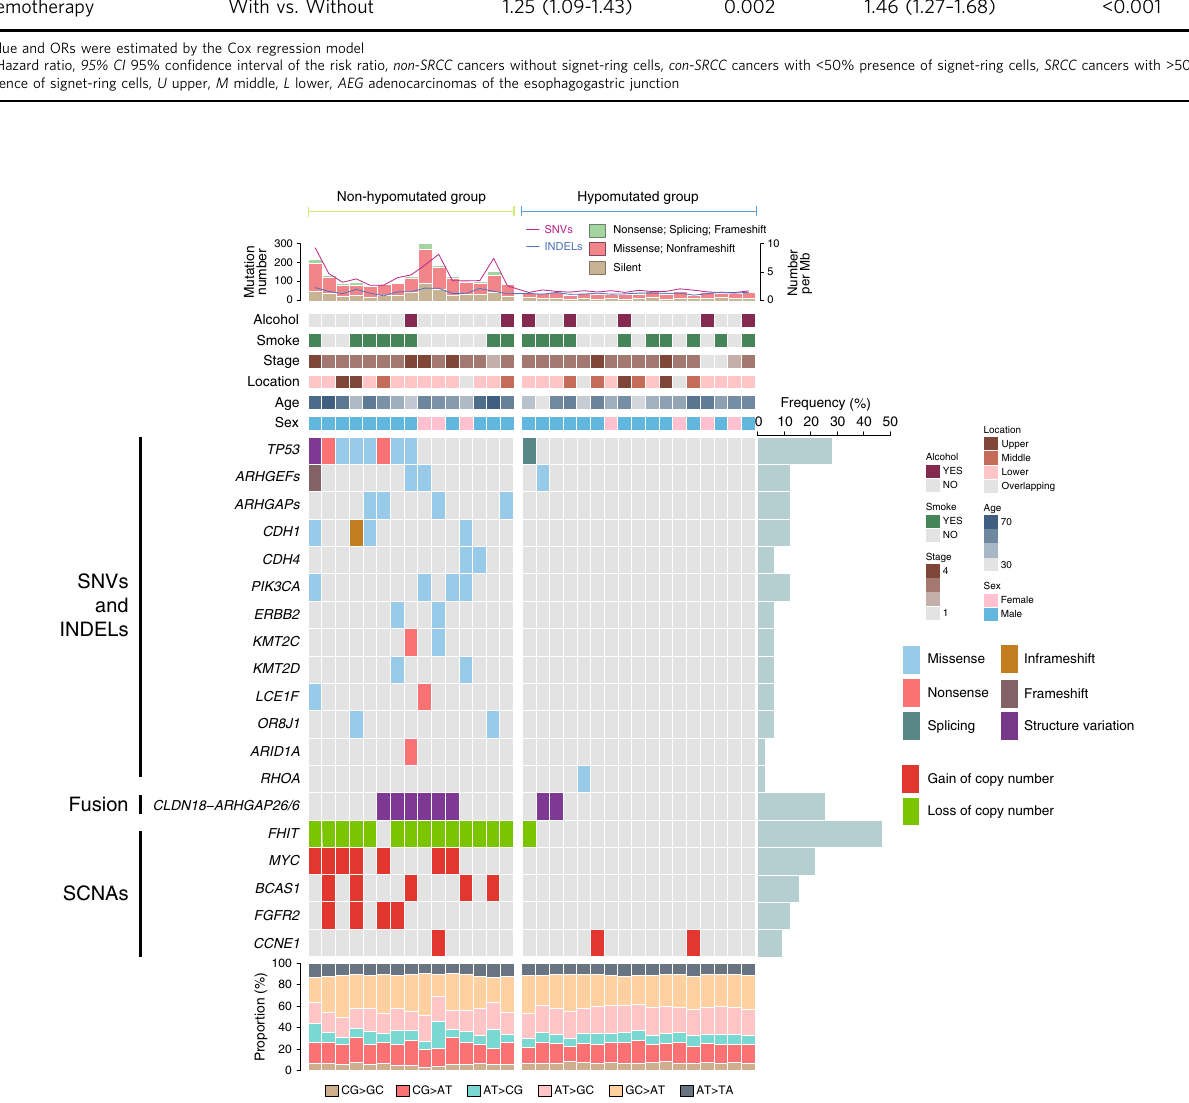
Fig. 2 Landscape of key genetic alterations in HSRCC of gastric cancer. The patient samples are shown on the x -axis. Information of mutation rate, alcohol history, smoke history, tumor location, stage, patient age, and sex are shown on the top of y -axis, followed by the key genetic alterations including signi fi cant mutated genes. Frequency of each alteration was illustrated on the right of the mutation heat